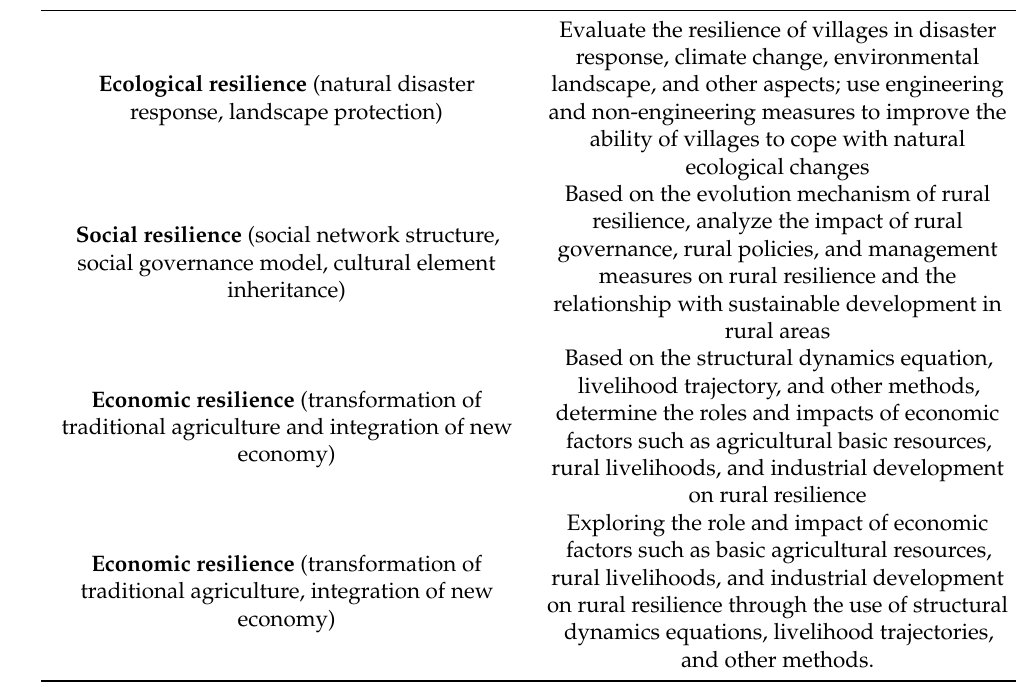
Table 1. Domestic and foreign rural resilience application fields (data source: reference